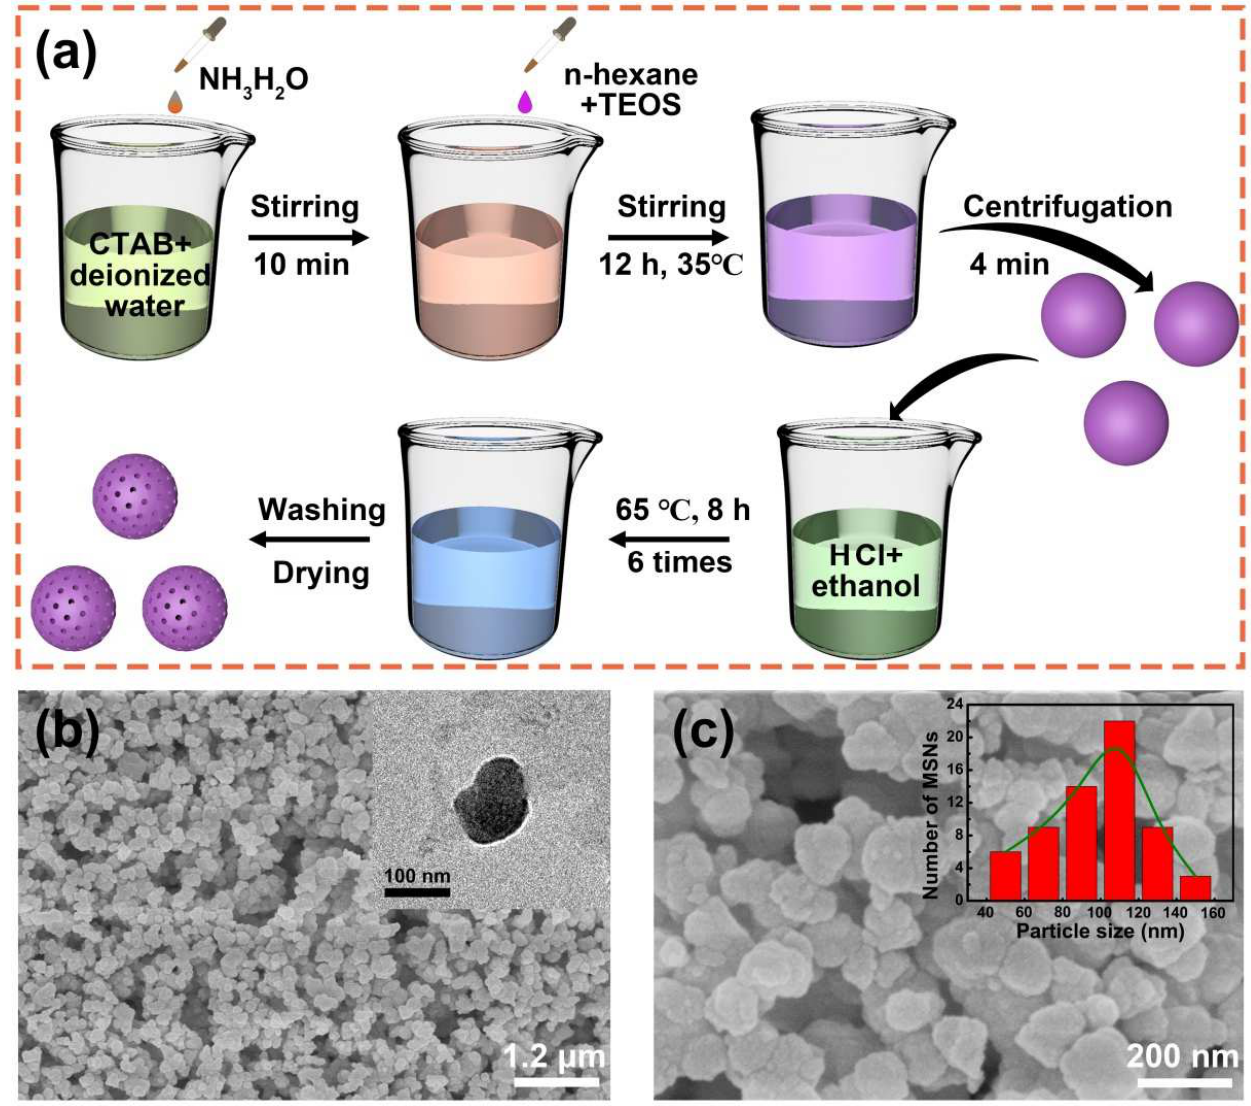
Figure 1. ( a ) A schematic diagram of the fabrication process for mesoporous silica nanoparticles (MSNs). ( b ) Scanning electron microscopy (SEM) image of MSNs, with the transmission electron microscopy (TEM) image of a single MSN in the insert. ( c ) An enlarged SEM image of MSNs. The insets in panel ( c ) show the statistical diameter distribution profile.